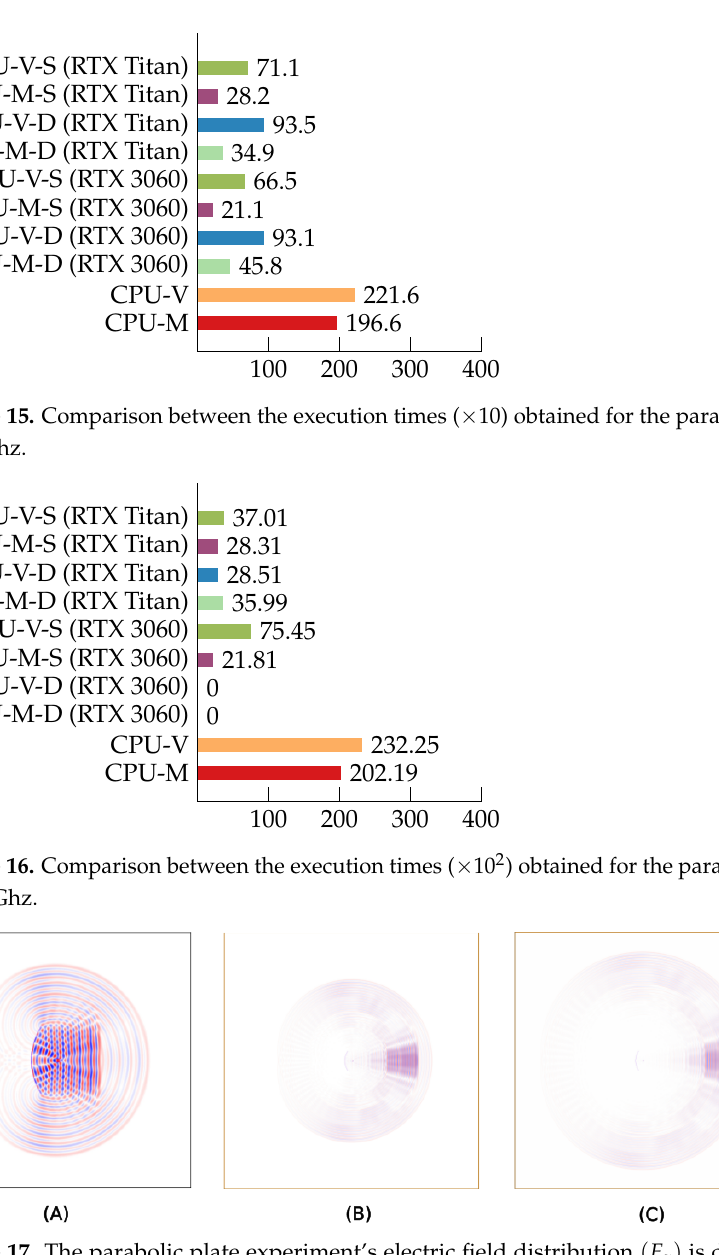
Figure 17. The parabolic plate experiment’s electric field distribution ( E z ) is depicted. Snapshots at 400 ( A ) and 750 ( B ), and 1160 ( C ) time steps are shown. The simulation lasted 1160 time steps, and the source was turned off at 580. Very similar results are obtained for the 5.00 GHz and 20 GHz frequencies. Table 14. MSE calculated for each control point compared with the reference solution (CPU). The val- ues used for the error calculation are transferred every fixed number of iterations, as shown in Figure